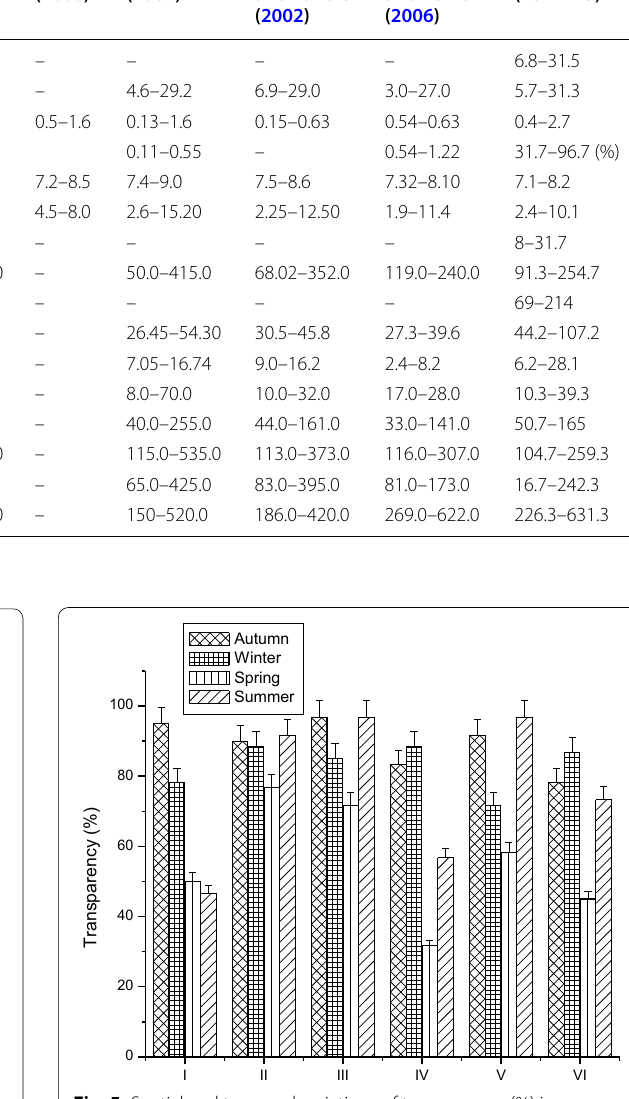
Fig. 5 Spatial and temporal variations of transparency (%) in Hokersar wetland during September 2012–August